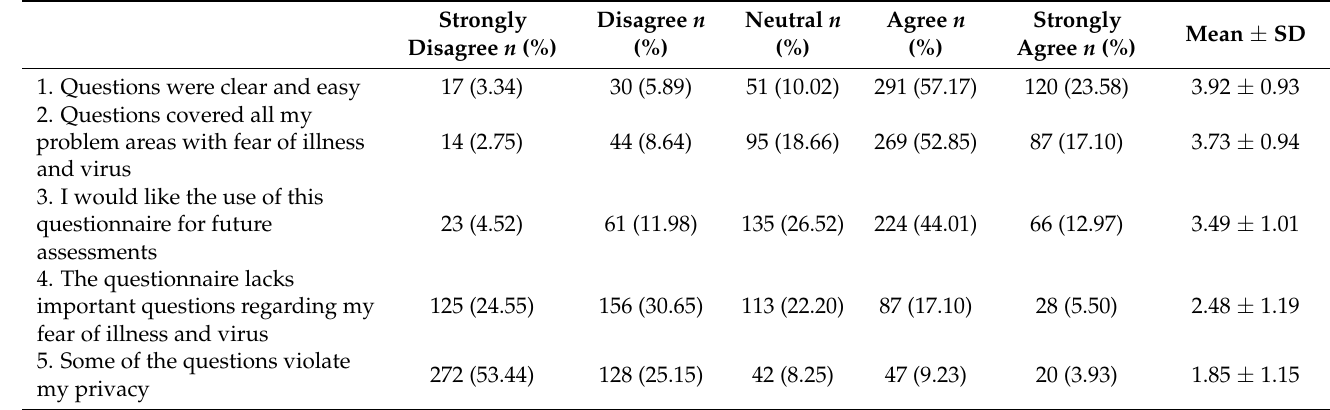
Table 3. Descriptive statistics for FIVE face validity.